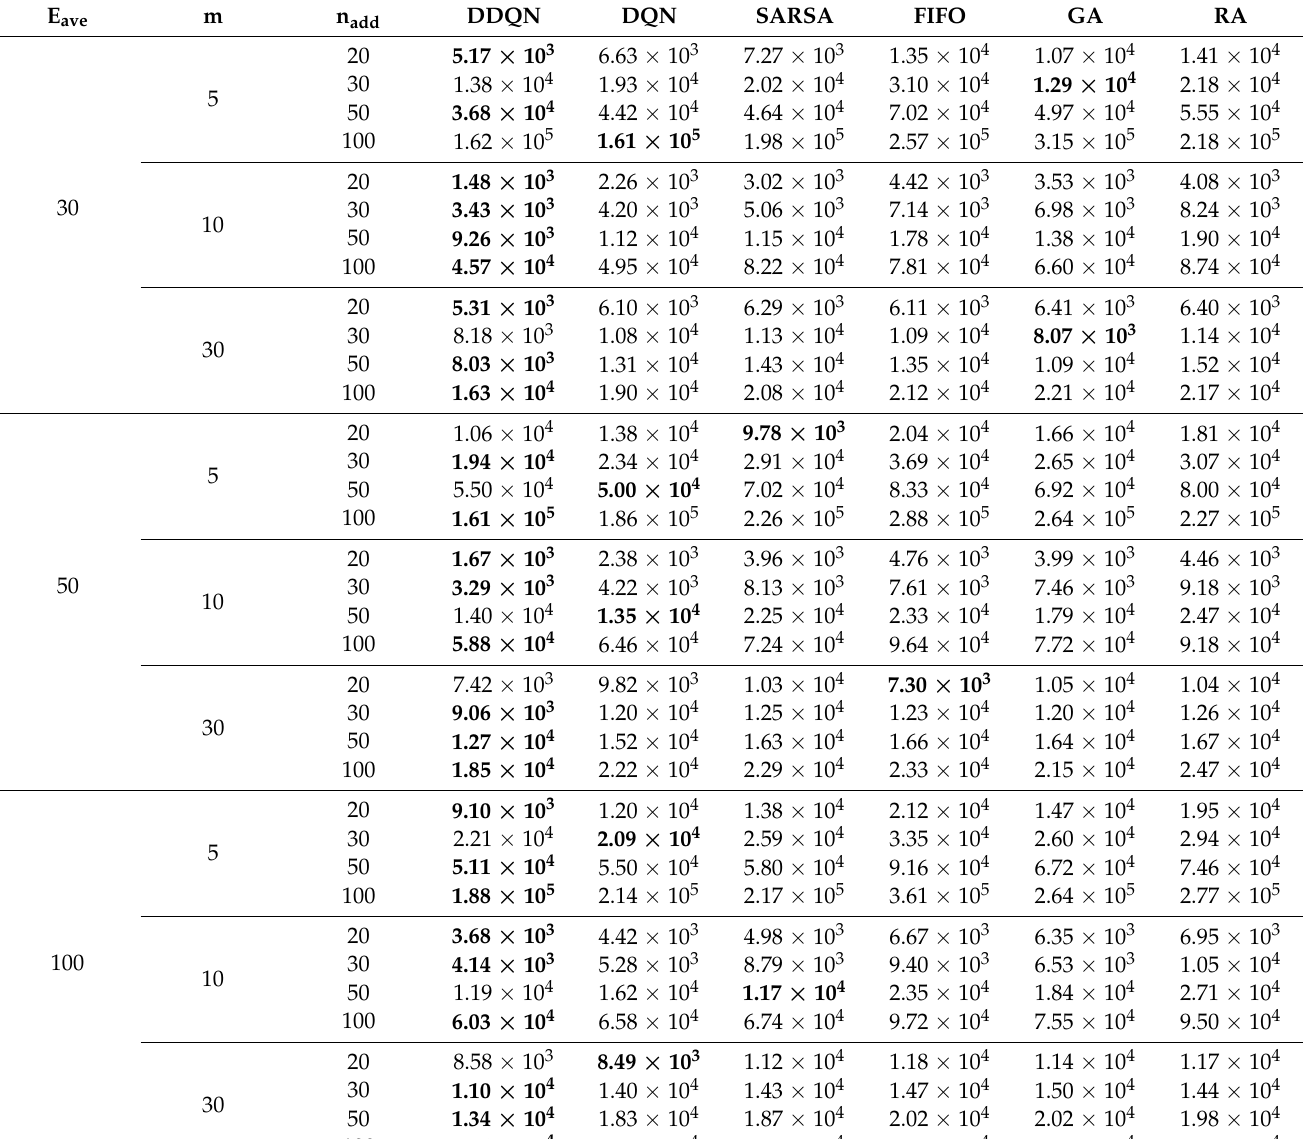
Table 5. Average total earliness and tardiness penalties of the different algorithms for each type of test (the best results are highlighted in bold